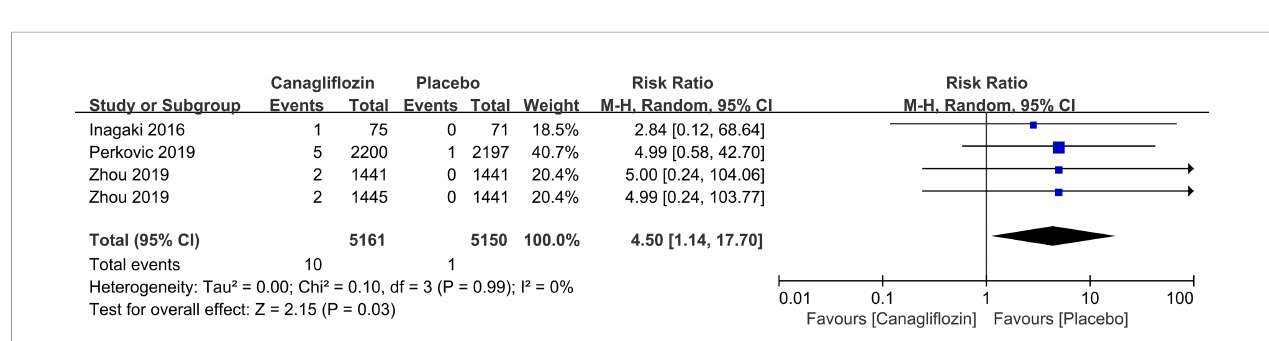
FIGURE 9 | Effect of empagli fl ozin on incidences of retinal disease compared with active hypoglycemic agents in T2DM patients.